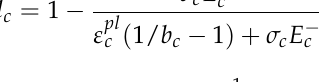
Figure 2. Assumed stress–strain model for ECC, ( a ) Tension, ( b ) and Compression. The compression and tension damage parameters ( d c and d t ) were calculated based on Equations (1) and (2), respectively [27].